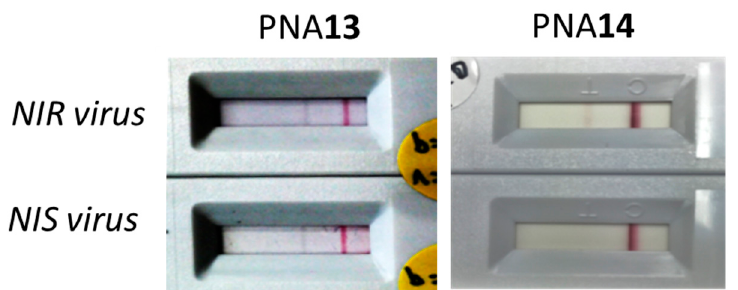
Figure 10. Rapid diagnosis of influenza virus by PNA chromatography. Top) Schematic diagram of the PNA chromatography kit. Top A) PNA / RNP formation, Top B) PNA / RNP detection, Top C) Confirmation. Bottom left) PNA 13 did not discriminate a SNP in the target viral RNA among the two viruses and detected both NIR and NIS viruses on the PNA chromatograph. Bottom right) PNA 14 discriminated a SNP in the target viral RNA among these two viruses and selectively detected NIR virus on the PNA chromatograph. PNA, 5 µ L (0.5 µ g); influenza viruses, 10 µ L (1.0 × 10 6 pfu / mL); elution bu ff er, 105 µ L (containing 1% Tween, 0.5% BSA). PNA and virus lysate incubation: 55 ◦ C, 5 min. Chromatography incubation: 55 ◦ C, 15 min.